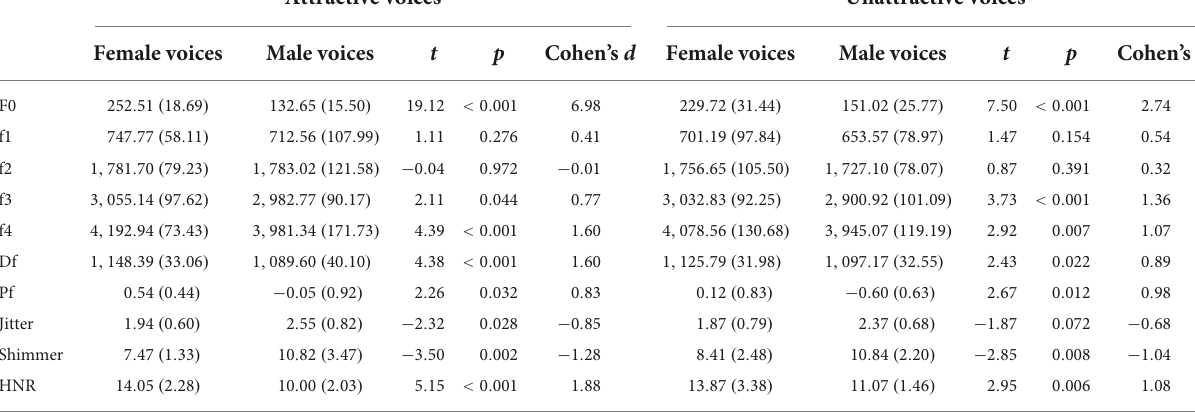
TABLE 2 Means (and standard deviations) and acoustic differences between female and male